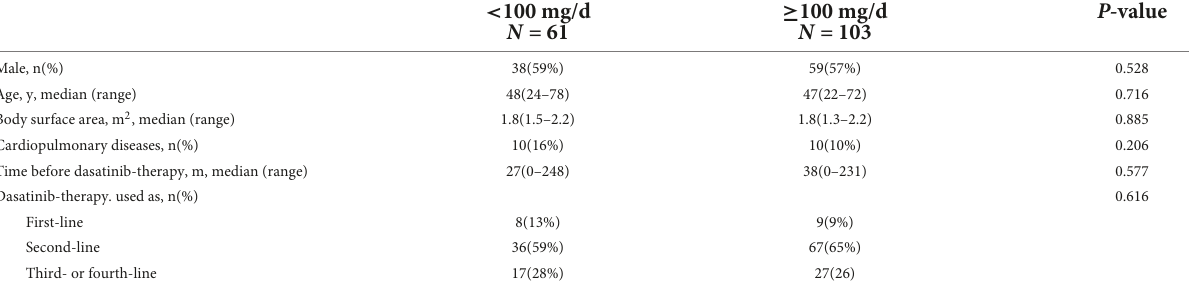
TABLE 3 Patients’ characteristics by propensity score matching analysis in cross-sectional cohort.